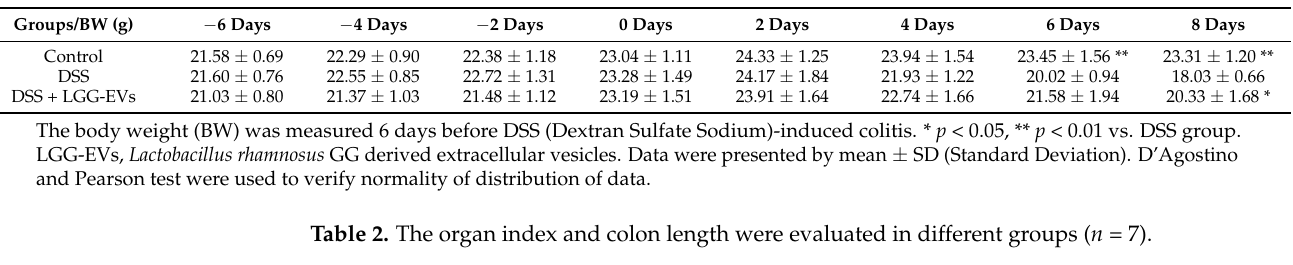
Table 4. Expression level of proteins in NF- κ B and NLRP3 signaling pathways upon LGG-EVs treat- ments.